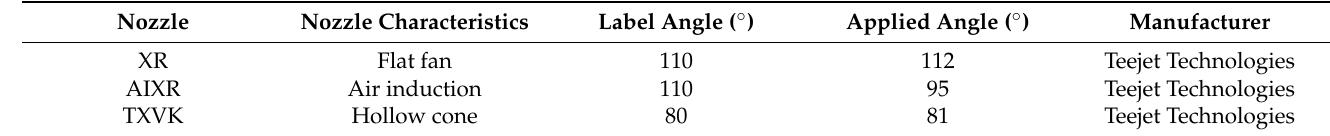
Table 1. Parameters of the nozzles used in this experiment.